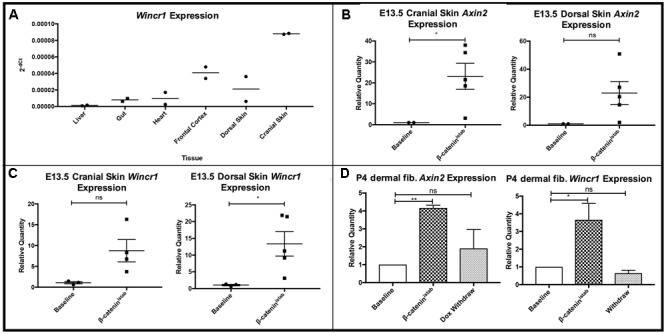
Wincr1 is differentially expressed in embryonic and perinatal mesenchyme and dynamically responds to changes in β-catenin activity levels. (A) Survey of Wincr1 mRNA levels in embryonic (E13.5) tissues reveals highest expression in embryonic cranial and dorsal skin (n = 2). (B)
Axin2 expression levels were used to validate β-catenin activity following doxycycline induction for 4 days in Engrailed1Cre/+; Rosa26rtTA/+; Teto-ΔN89 (β-catistab) E13.5 primary fibroblasts in vitro. (P-value = 0.0237, n = 2,5). (C) Relative quantity of Axin2 and Wincr1 mRNA in β-catistab E13.5 embryonic fibroblasts. (D) Relative quantity of Axin2 and Wincr1 mRNA in β-catistab P4 fibroblasts following doxycycline induction for 4 days and subsequent withdrawal for 2 days in vitro. ∗P-value ≤ 0.05, ∗∗P-value ≤ 0.01.